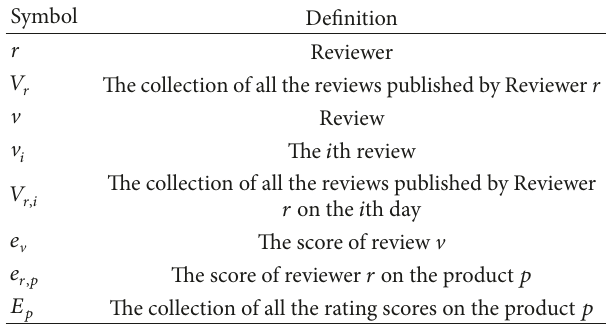
Table 1: Symbol definition table.